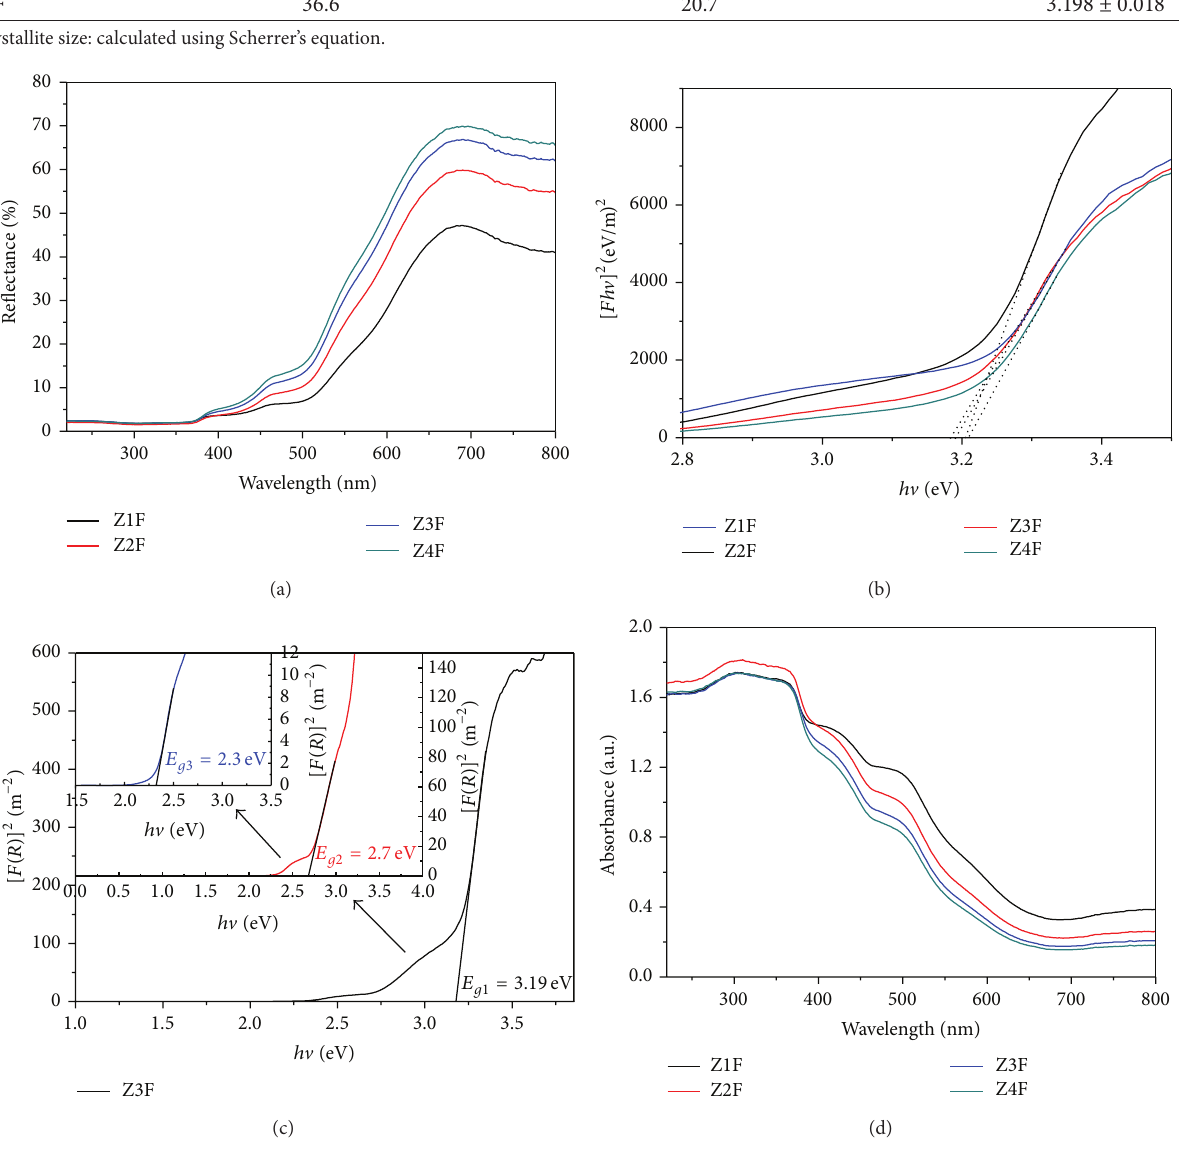
Figure 3: Kubelka-Munk transformed reflectance spectra of (a) reflectance spectra of ZnO/ZnFe 2 O 4 nanocomposite, (b) band-gap energy of ZnO,(c)Kubelka-MunkplotZnO/ZnFe 2 O 4 nanocomposite(forsampleZ3Fasanexample),and(d)diffusereflectanceUV-visibleabsorption spectra of calcined Zn-Fe-LDH